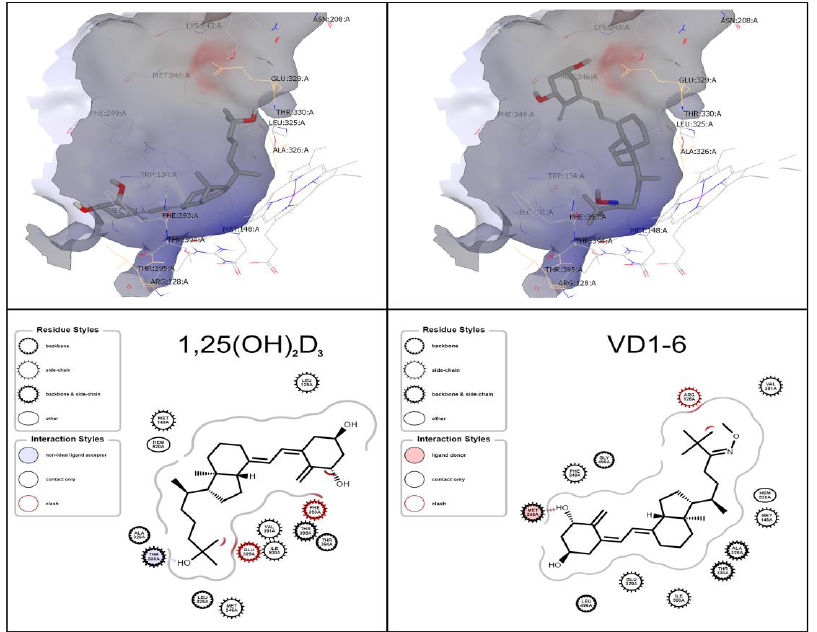
Figure 2. OEDocking simulated orientation of 1,25(OH) 2 D 3 ( left ) and VD1-6 ( right ) in the CYP24Al active site. Depicted as a 3D binding pocket view, using VIDA ( upper panels ), and ligand-interaction diagram ( lower panels ), using the OEChem toolkit.